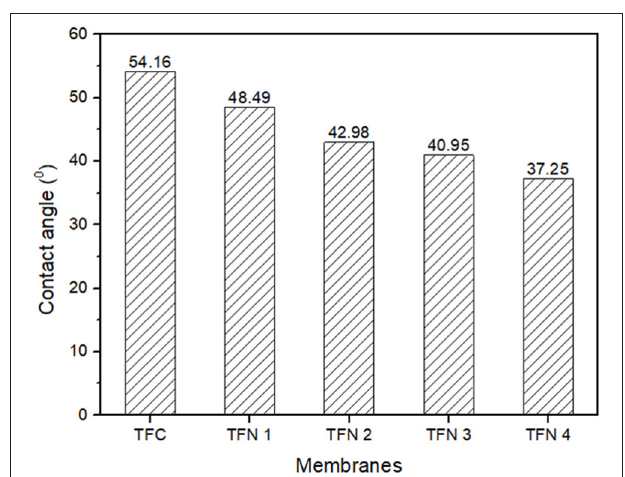
FIGURE 6 | Membrane surface